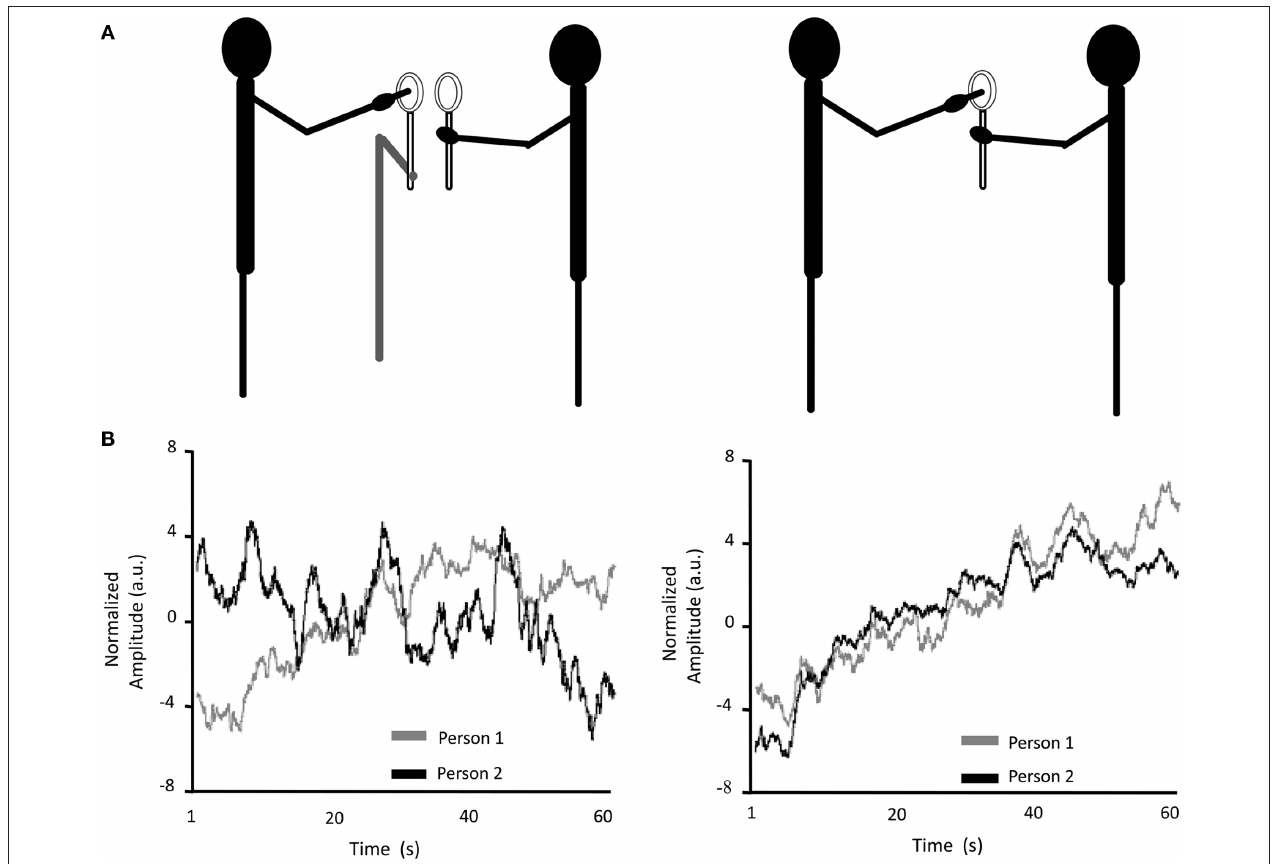
task (right) conditions. The striking coordination in the interpersonal-task condition was confirmed by cross-recurrence quantification analysis, which revealed a greater degree and higher stability of coupling in that